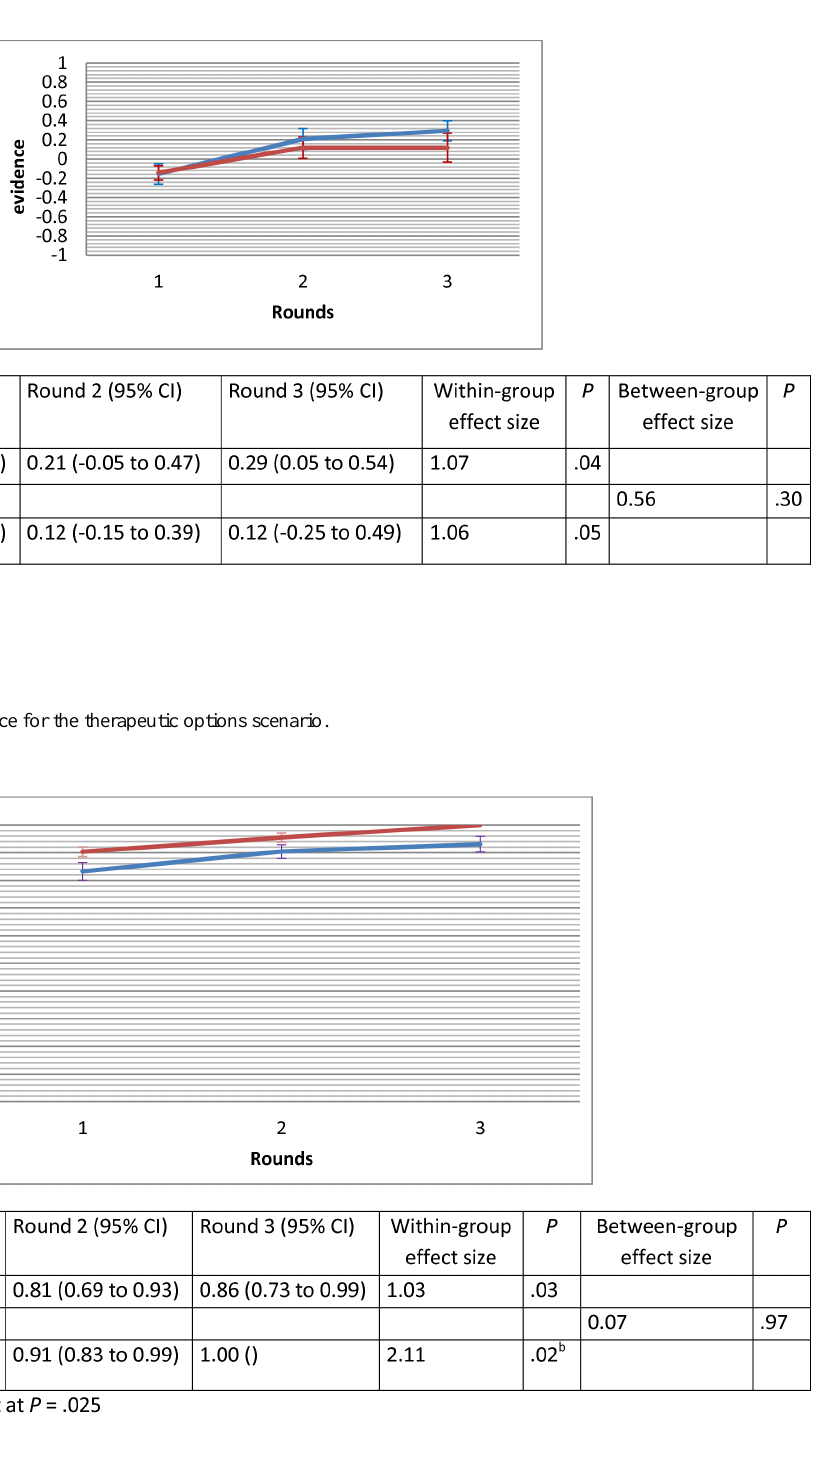
Figure 9. Concordance with clinical evidence for the medical imaging scenario.